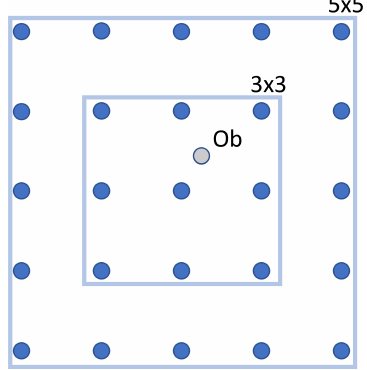
Figure 3. Example of forecast grid point selections for different HiRA neighbourhoods for a single observation point. A 3 × 3 do- main returns nine points that represent the nearest forecast grid points in a square around the observation. A 5 × 5 domain encom- passes more points.